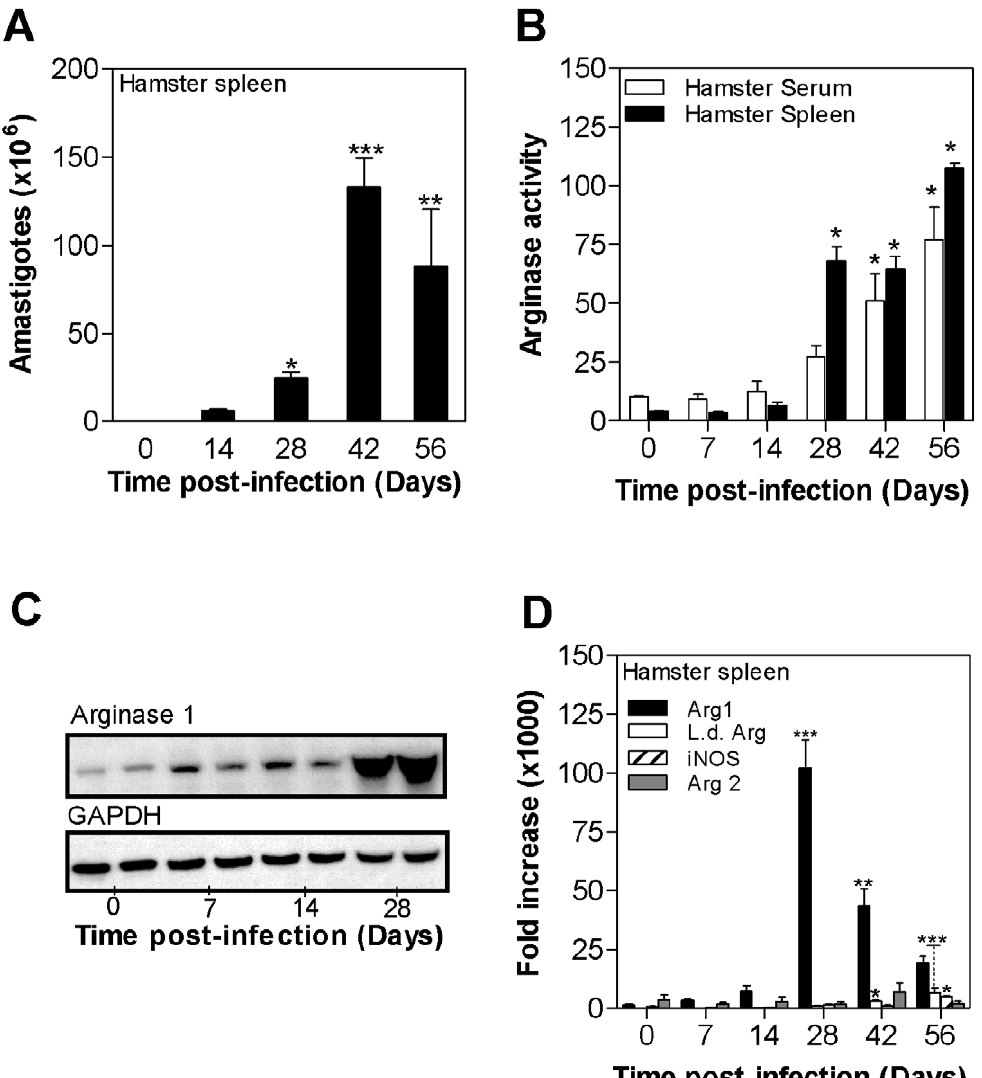
Figure 2. Kinetics of arginase expression in spleen tissue during progressive visceral leishmaniasis. A ) Parasite burden in the spleens of hamsters (n=6 per group) infected with L. donovani for 14, 28, 42, and 56 days. The mean and SEM (error bars) of the parasite burden, determined by luminometry and interpolation from an amastigote standard curve, is shown from a single experiment that is representative of 2 independent experiments. B ) Arginase activity in the serum (open bars) and spleen tissue (filled bars) of uninfected hamsters (Day 0) and hamsters infected with L. donovani (n=6 per group) for 7, 14, 28, 42, and 56 days. The mean and SD of the tissue arginase activity, determined by assay of urea production, is shown. C ) Hamster arg1 protein expression determined by western blot in spleens of control hamsters (0 days post-infection) and hamsters infected with L. donovani for 7, 14, and 28 days. The expression of GAPDH is shown as a control for protein loading. Each lane contains splenic lysate from a single hamster, with two lanes per time point. The anti-arginase antibody did not react with parasite arginase by immunoblot. D ) Time course of expression of hamster arg1 mRNA (filled bars), L. donovani arginase mRNA (empty bars), hamster NOS2 (iNOS) mRNA (hatched bars), and hamster arg2 mRNA (hatched bars) in spleens of control hamsters (0 days post-infection) and hamsters infected with L. donovani for 7, 14, 28, 42, and 56 days. The mean and standard deviation (error bars) of the fold-increase of arginase mRNA relative to BHK cells, determined by real time RT-PCR in groups of 6 animals, is shown from a single experiment that is representative of 3 independent experiments. The statistical significance of differences in each of the panels is identified by asterisks (*, p , 0.05; **, p , 0.01; ***, p , 0.001).